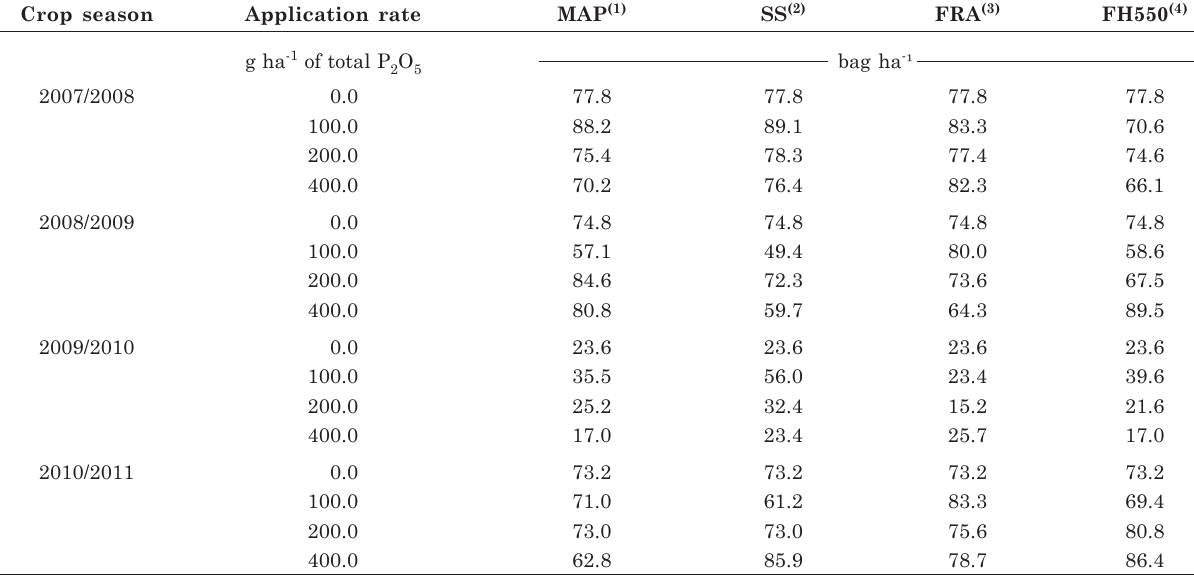
Figure 1. Content of P-Mehlich-1 in the soil, collected under the canopy of the coffee plants in September in the 0-20 cm layer in 2008 and 2009, as a function of the rates of P 2 O 5 applied under the forms of simple superphosphate (a), monoammonium phosphate (b), FH 550 ® (55 % natural reactive rock phosphate from Algeria (Djebel-Onk) and 45 % simple superphosphate) (c), and natural reactive rock phosphate from Algeria (Djebel-Onk) (d). ** significant at 1 %. Table 2. Coffee yield as a function of different sources and application rates of P over a period of four crop